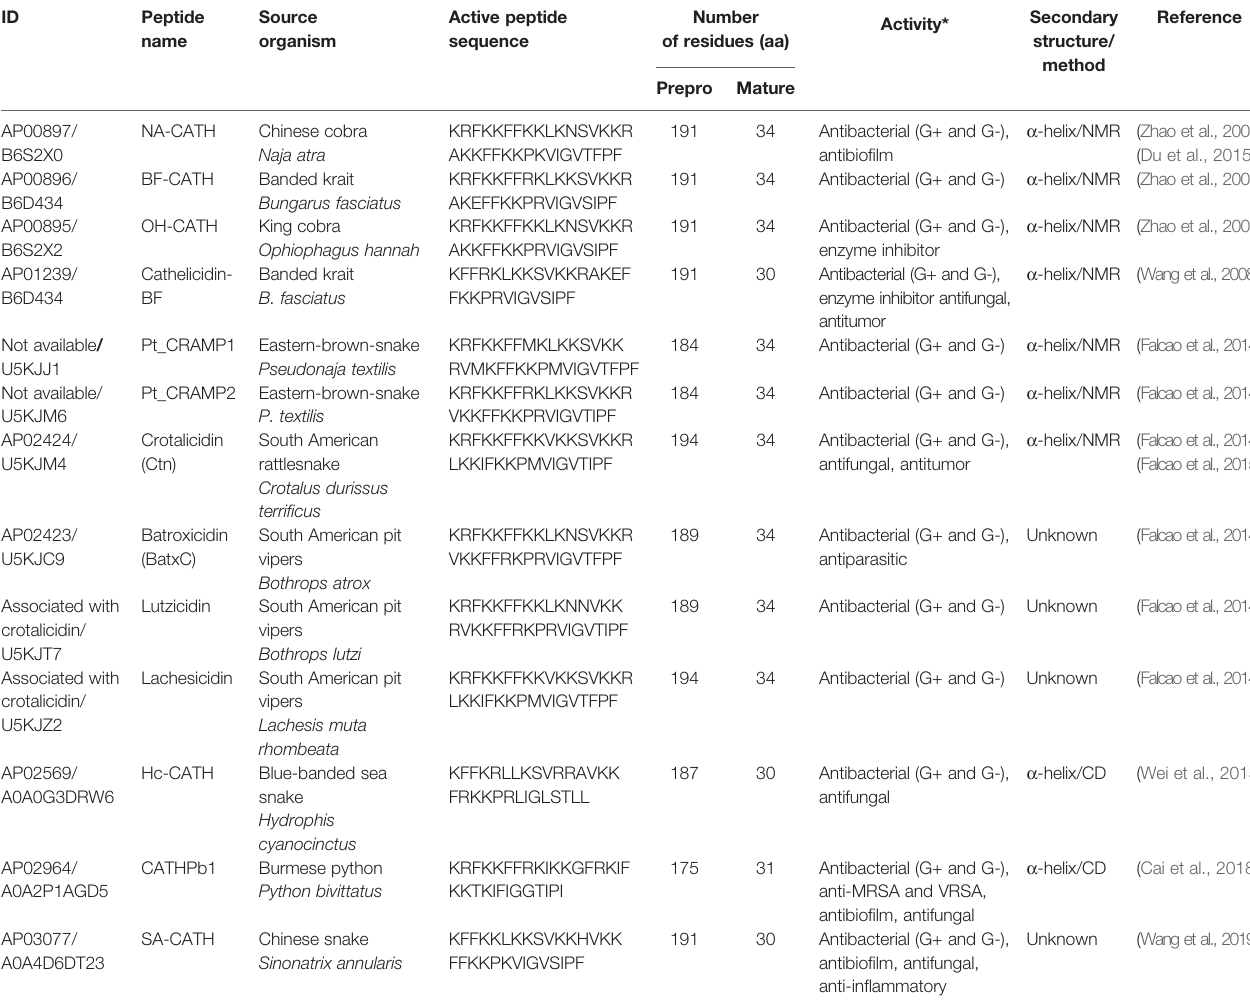
TABLE 1 | Snake venom CRAMPs deposited in the Antimicrobial Peptide Database (APD), access to mature peptide and UniProtKB for precursor